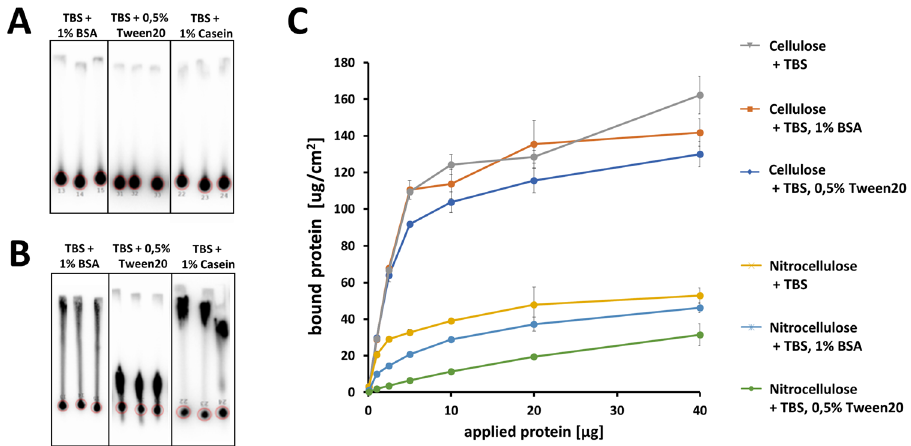
Figure 2. Cellulose and nitrocellulose binding studies using CBM protein, determining the influence of different buffer additives. 125 I radiolabeled CBM protein was applied to ( A ) cellulose-paper stripes or ( B ) nitrocellulose membrane. After drying, application of buffer solution containing different additives, protein localization and quantitative analysis of bound and washed-off protein was analyzed using phosphor imaging (Figure S3). ( C ) Quantitative analysis of protein-binding towards cellulose and nitrocellulose was performed according to Figure S4. Standard derivation was calculated using data derived from experimental triplicates.